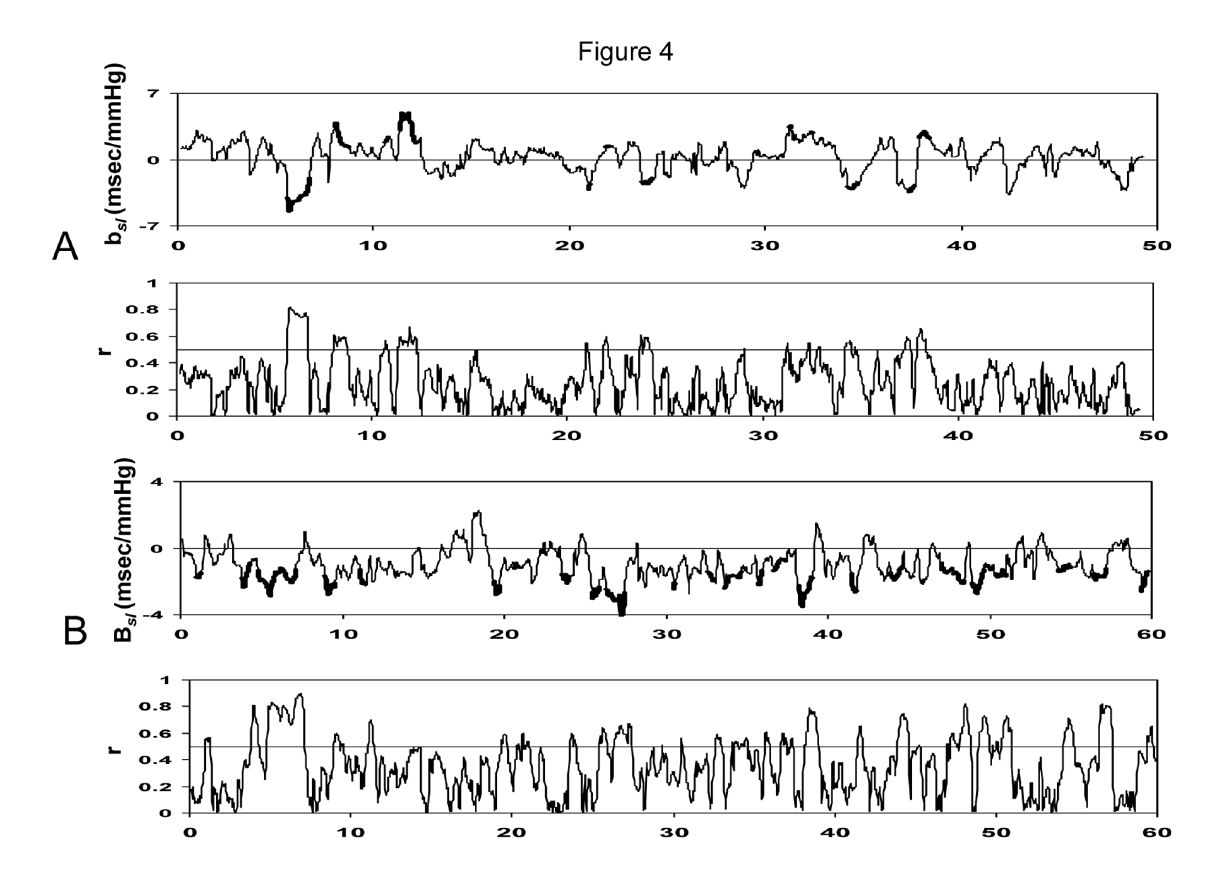
Figure 4. Representative tracings of b (the slope of 1 min IBI-SBP regression line assessed by 1 min sliding window sl method), and r-the correlation coefficient as a function of time during the whole session of the recording in a control (upper panels, A) individual and in a transplanted patient (lower panels, B). The bold portions of b with a correlation coefficient (r) between IBI and SBP greater than 0.5. In the control patient’s tracing, 55% of episodes in such epochs were baroreflex with a positive b , while the remaining 45% were non-baroreflex with a negative b sl transplanted patient is shown in Figure 4, lower panel. In this patient, all sequences (100%) were nonbaroreflex episodes. doi: